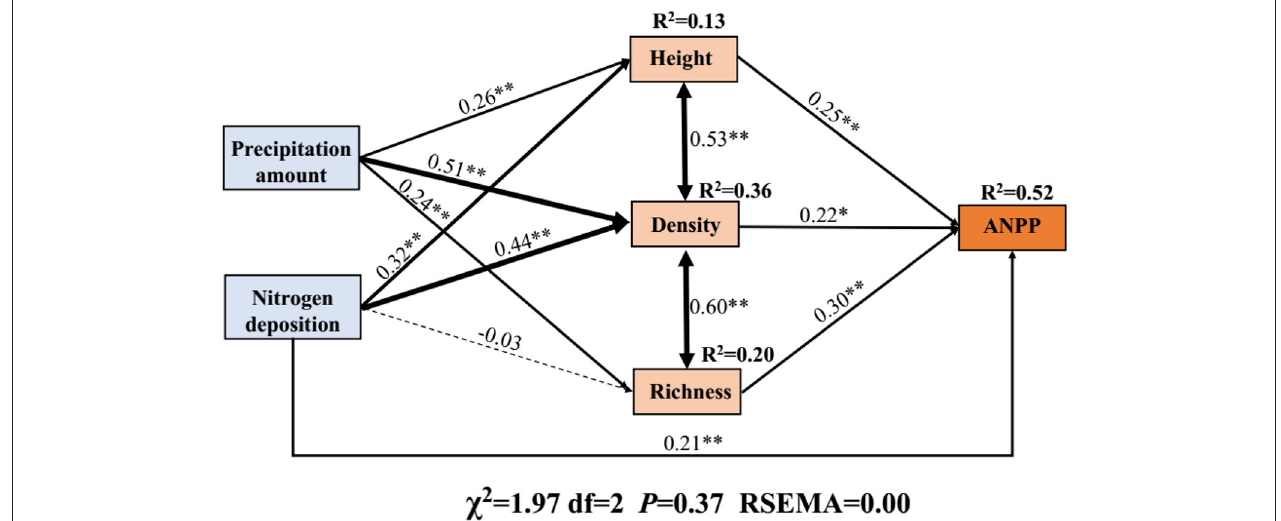
FIGURE 5 | Structural equation model (SEM) representing the effects of precipitation change, nitrogen application, and their integrated impacts on ANPP. The SEM considered all plausible pathways through which plant traits influence ANPP. Solid lines represent the positive paths, and dashed lines indicate negative paths. Arrow width is proportional to the strength of the relationship. *Indicates P < 0.05 and **indicates P < 0.01. R 2 represents the proportion of the variance for each dependent variable in the